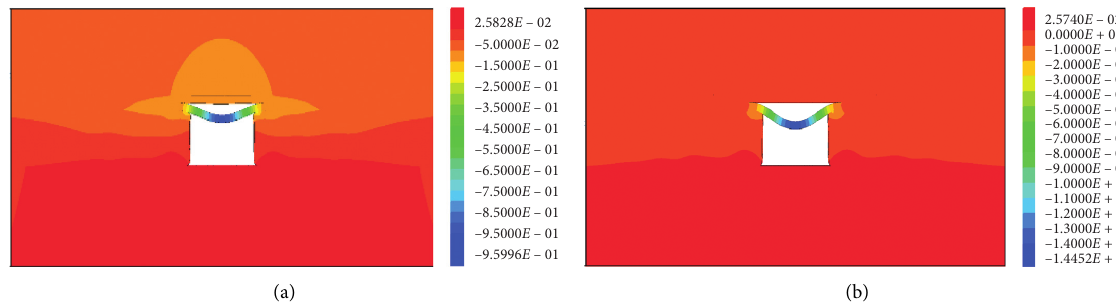
Figure 11: Roof sag of different rock-coal interfacial friction angles: (a) 10 ° and (b) 20 °